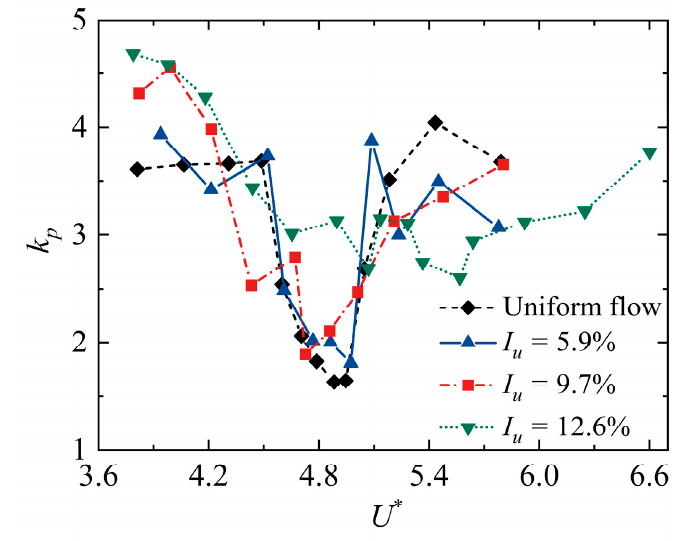
Figure 12. The variation in k p versus U * for different I u .